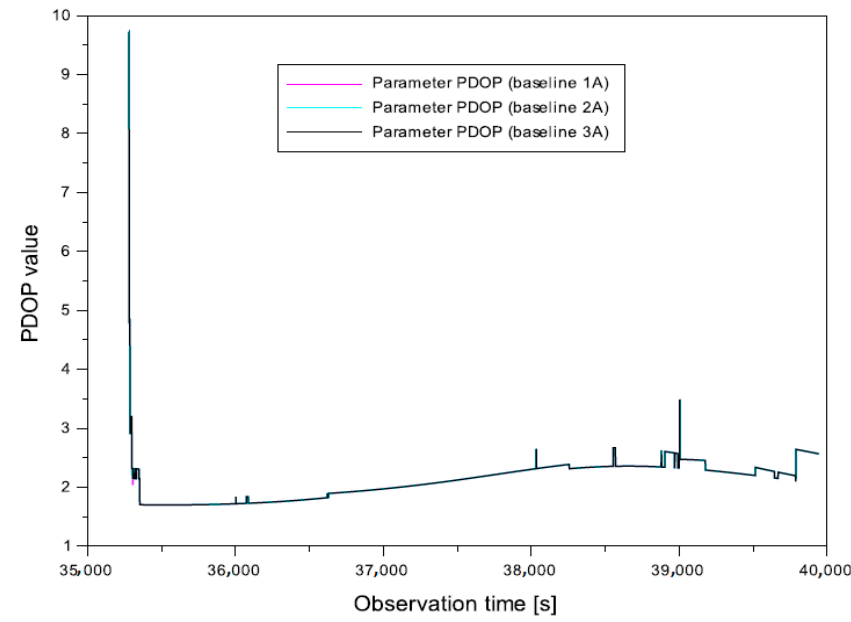
Figure 17. The results of PDOP values for each baseline in flight test in D ę blin.